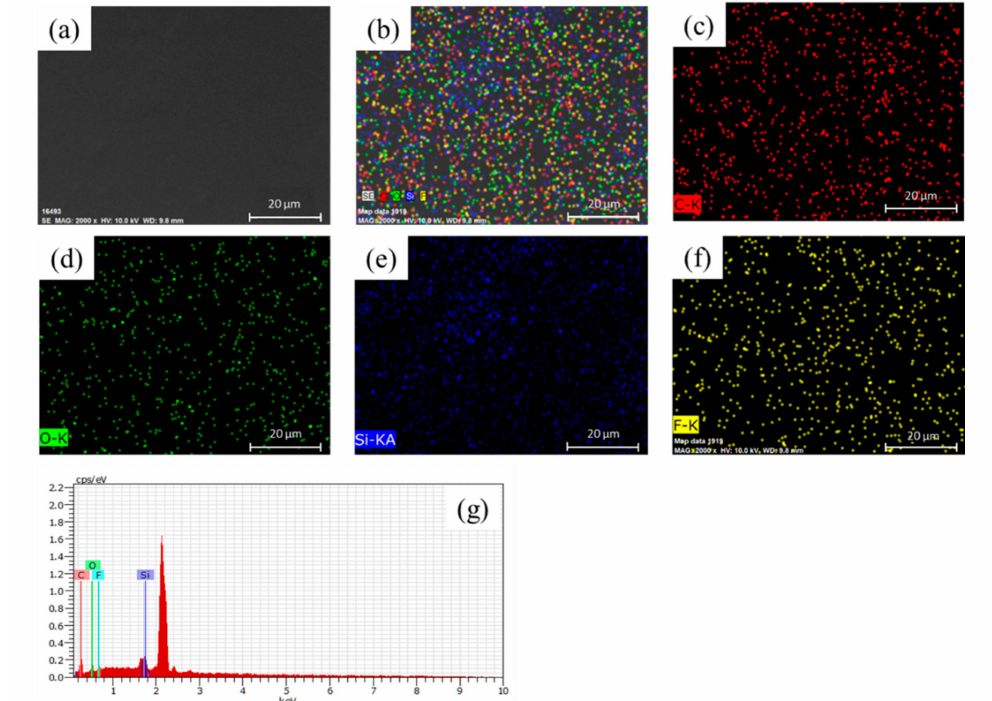
Figure 6. The mapping and EDS analysis nanohybrid silica polyacrylate film prepared by weight ratio of DFMA/MMA at 1:5. ( a ) SEM image of the as-prepared film, ( b ) mapping of C, O, Si, amd F elements on ( a ), ( c ) mapping of C element on ( a ), ( d ) mapping of O element on ( a ), ( e ) mapping of Si element on ( a ), ( f ) mapping of F element on ( a ), and ( g ) EDS analysis of the as-prepared